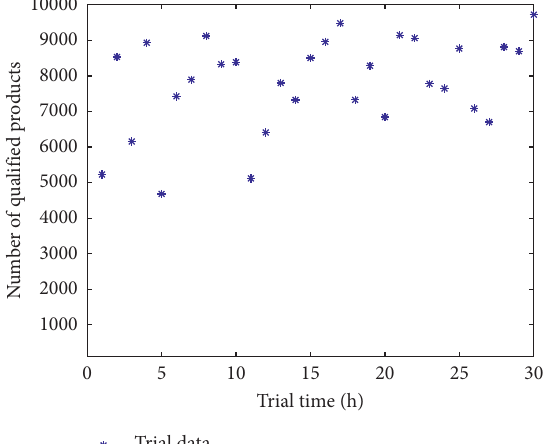
Figure 2: Failure trial of the industrial